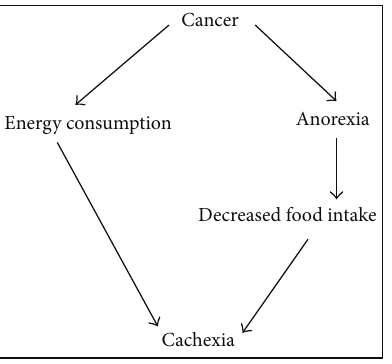
Figure 1: Traditional view of cachexia as discussed by Tisdale [8].